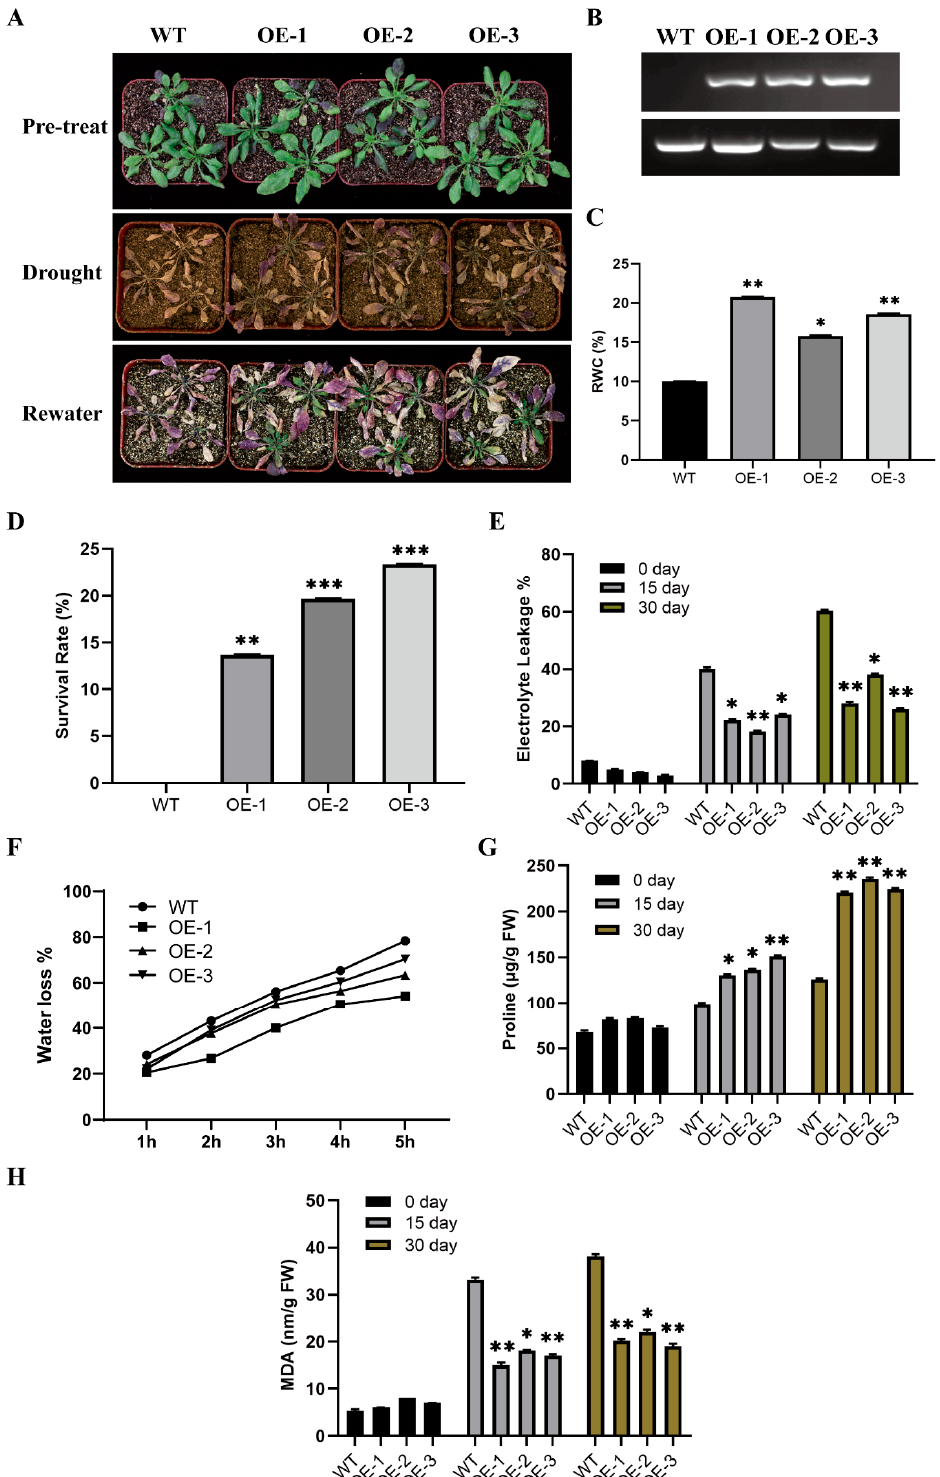
Figure 3. Drought tolerance analysis in GhWOX4 overexpressed transgenic Arabidopsis lines. ( A ) Phenotypic comparison of seedlings grown to observe drought tolerance. ( B ) GhWOX4 expression in WT and OE lines analyzed by semi-quantitative (RT) reverse transcription PCR. ( C ) Measurement of relative water content percentage. ( D ) Survival rate percentage after 30 days natural drought and 1 week re-water. ( E ) Electrolyte leakage percentage. ( F ) Water loss percentage. ( G ) Proline content. ( H ) Melondialdehyde (MDA) content. The data represent the means ± SE from three independent experiments, t-tests: * p < 0.05, ** p < 0.01, *** p <